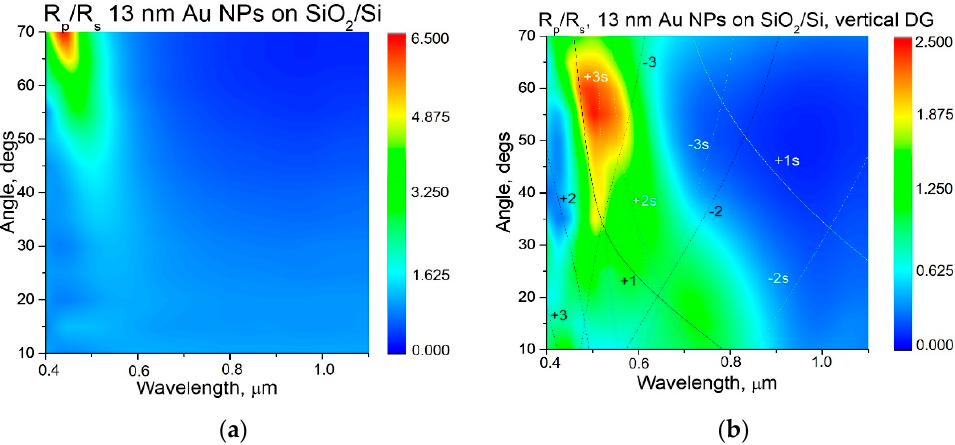
Figure 6. Comparison between samples with 13 nm Au NPs on oxidized flat Si ( a ) and on oxidized Si with vertically aligned diffraction grating (DG) ( b ). Dispersion curves ( b ) for surface plasmon-polariton waves for two boundaries, air/gold (±1, 2, and 3) and gold/silica (±1s, 2s, and 3s), are shown for different diffraction orders 1, 2, and 3 (shown on the figures).